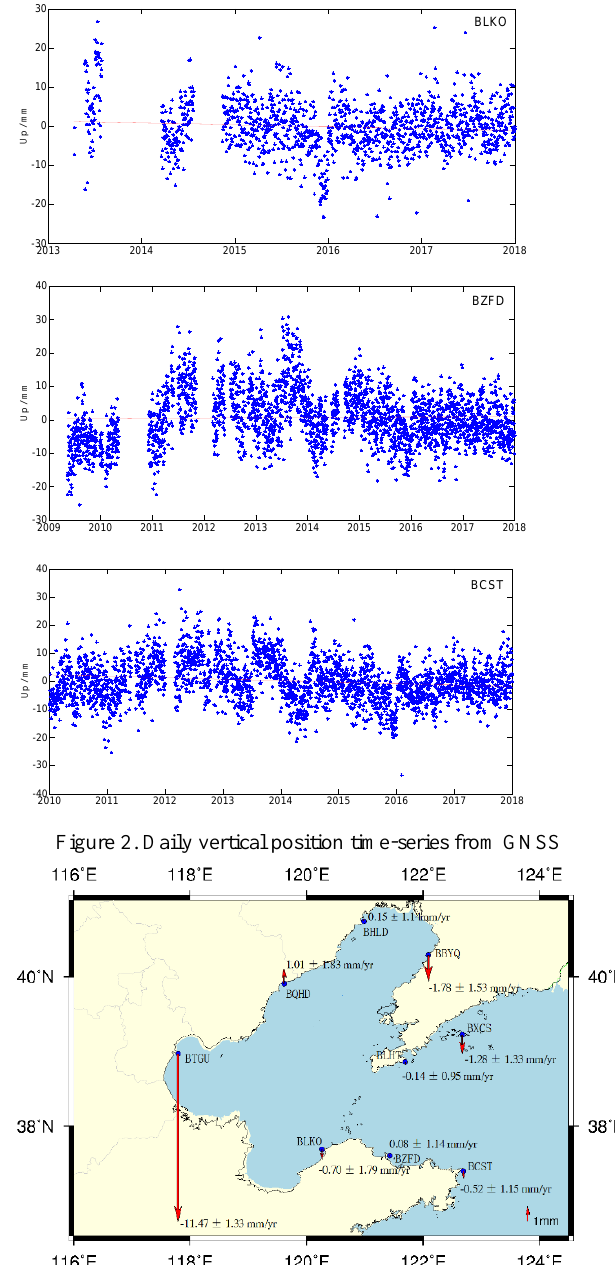
Figure 2. Daily vertical position time-series from GNSS